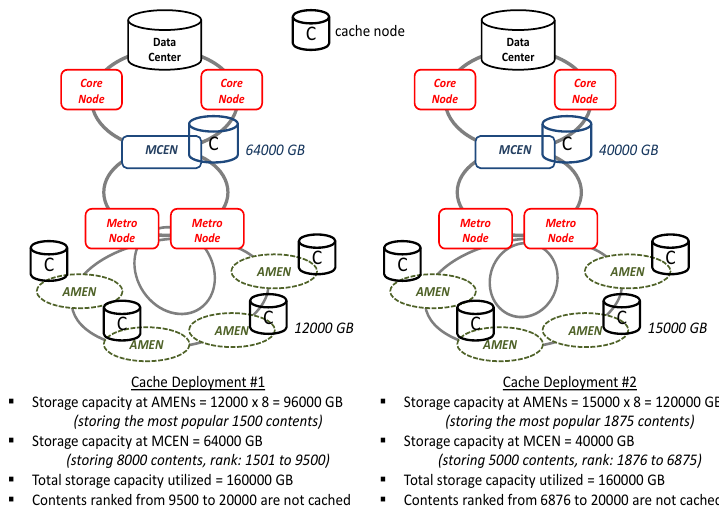
Figure 3. Example of two random storage capacity distribution approaches, each leading to a cache